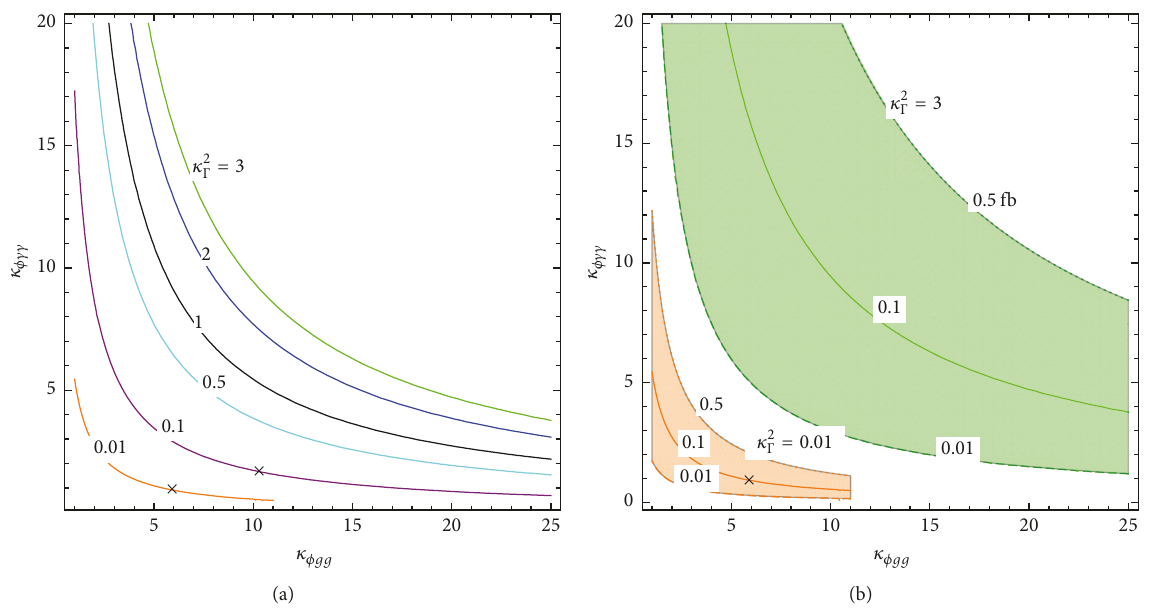
Figure 8: For various 𝜅 2 Γ shown, 𝜅 휙푔푔 and 𝜅 휙훾훾 leading to 𝜎 휙 × BR 훾훾 = 0.1 fb (a) and the regions 0.01 ≤ 𝜎 휙 × BR 훾훾 ≤ 0.5 fb (b) for 𝜅 2 Γ = 0.01, 3 (orange and green, resp.) with 𝑀 휙 = 1000 GeV, for the choice of the reference mass scale 𝑀 = 1 TeV. The plots apply to any model with a 𝜙 as here, with the “ × ” showing the values for the particular model of Section 2 with parameter values as listed in the text.